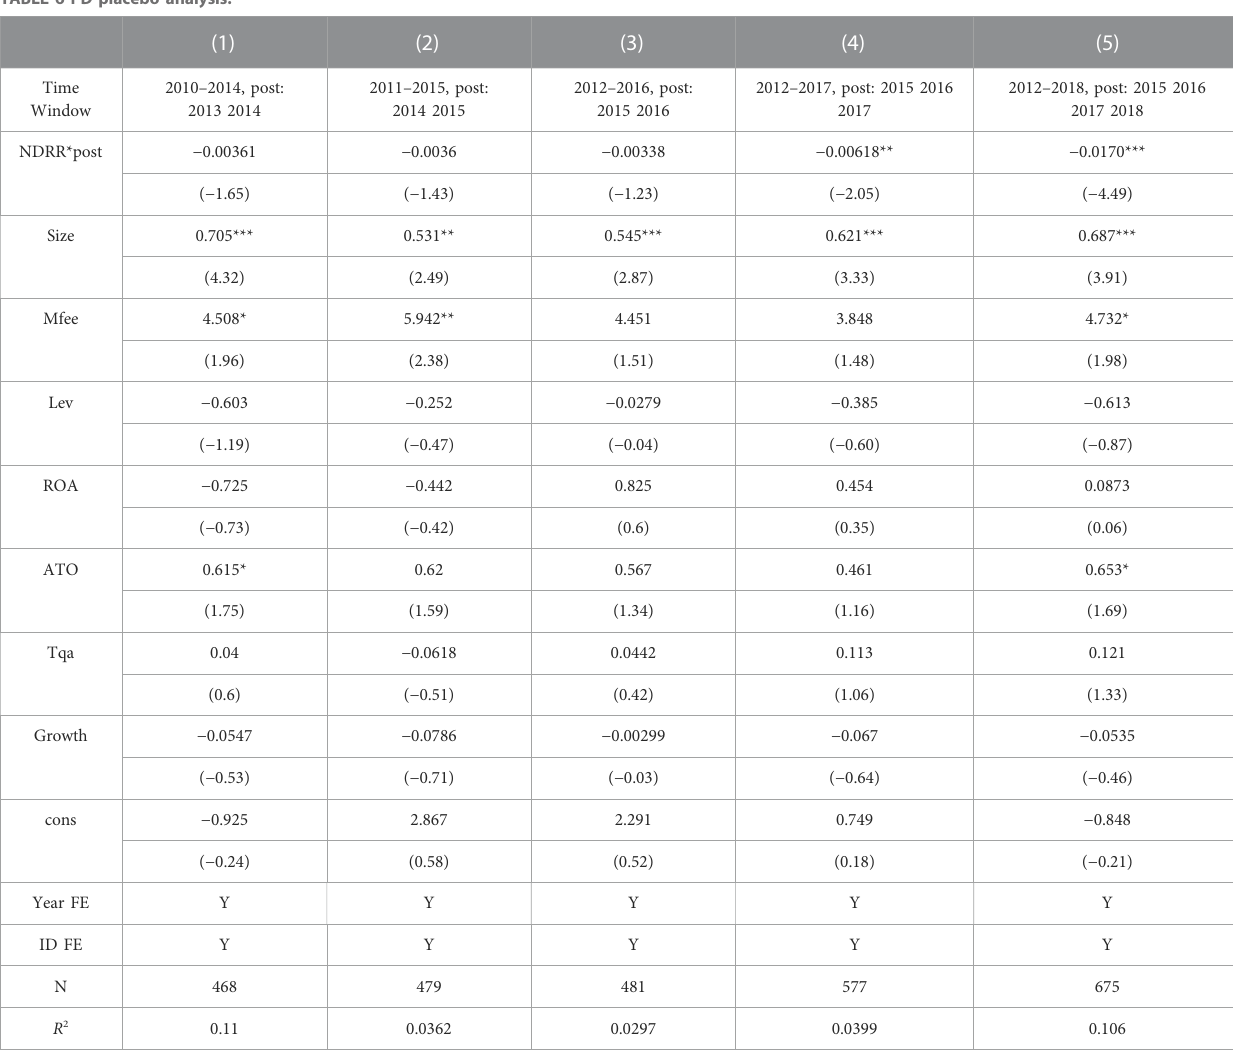
TABLE 6 PD placebo